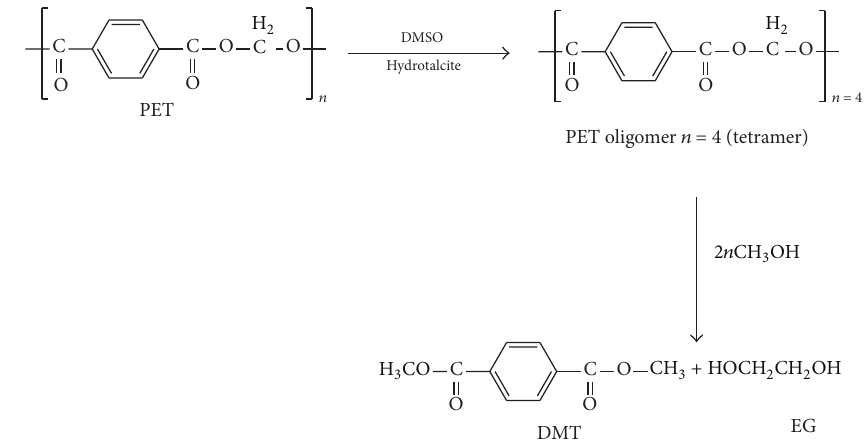
Scheme 2: Mechanism of PET degradation by using hydrotalcites [14].